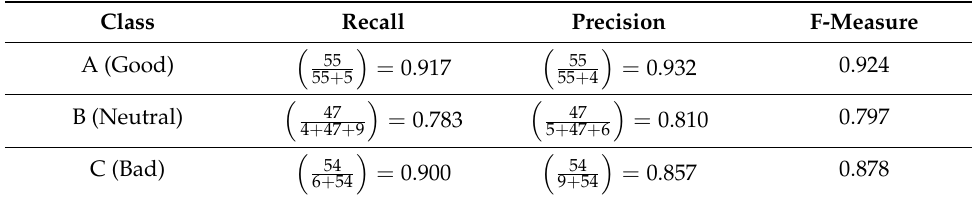
Table 8. Results of Recall, Precision, F-measure.